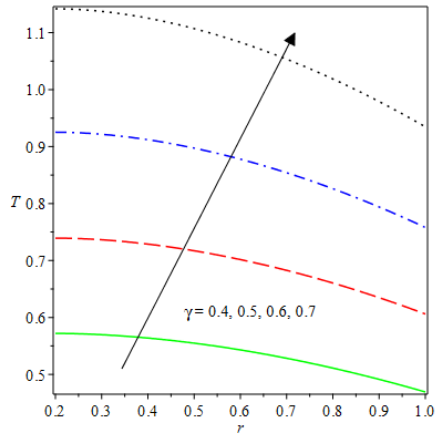
Figure 11. Heat transfer for different ( γ )